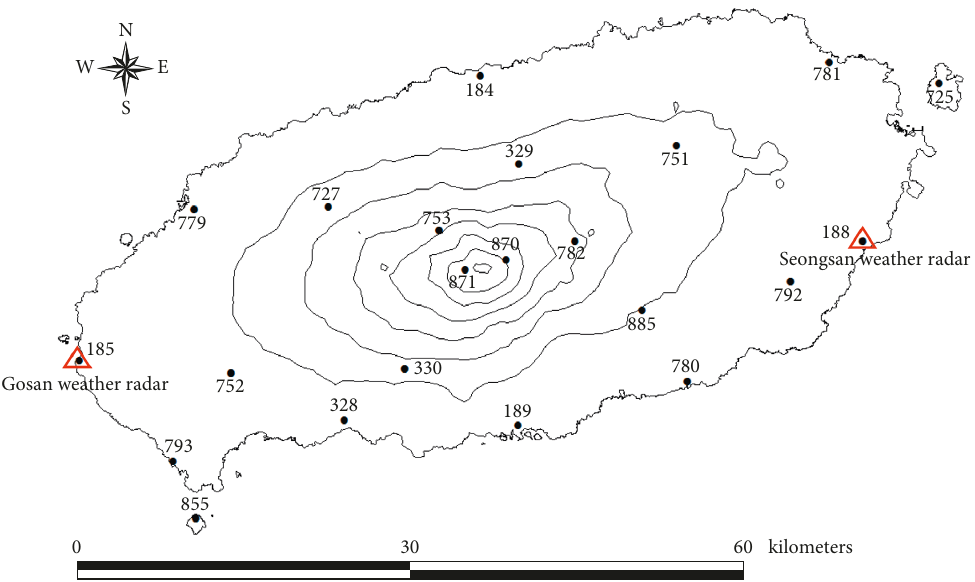
Figure 4: Locations of rain gauges over Jeju Island and two radars located at Gosan and Seongsan, Jeju Island.